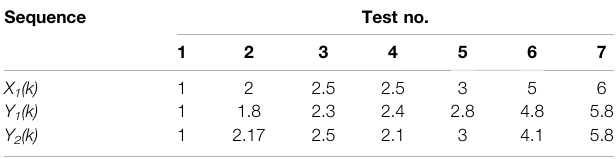
TABLE 4 | Example sequence of the fuzzy correlation degree. Sequence Test no.